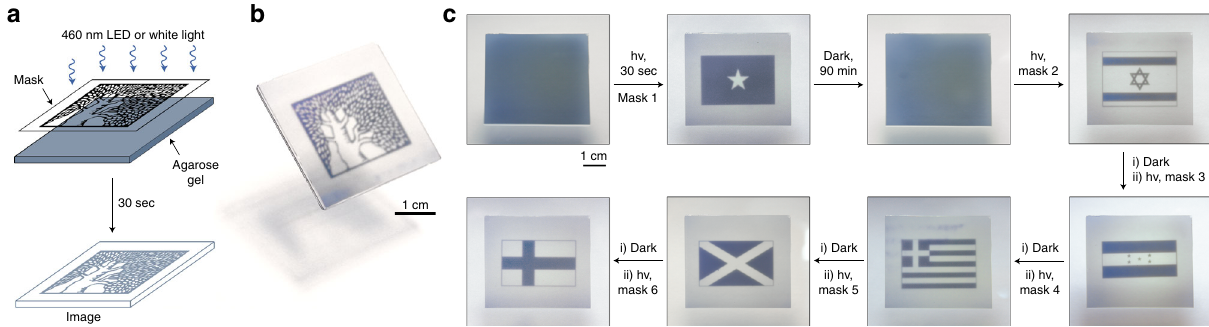
Fig. 5 Writing self-erasing images in a photoresponsive gel soaked with an inclusion complex. a , Creating an image in a 5 ⊂ 4 -soaked agarose gel by exposing it to light through a mask (here, featuring the logo of the Weizmann Institute of Science) and b , a photograph of the resulting image. c , A series of images ( fl ags of Somalia, Israel, Honduras, Greece, Scotland, and Finland) created consecutively in the same piece of